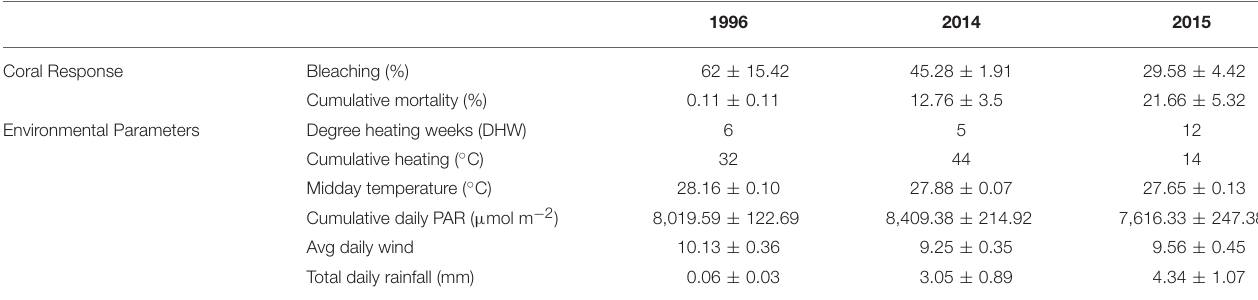
TABLE 4 | Summary comparision of coral response and enviornmnental parameters for all documented bleaching events in K ¯ ane‘ohe, O‘ahu,